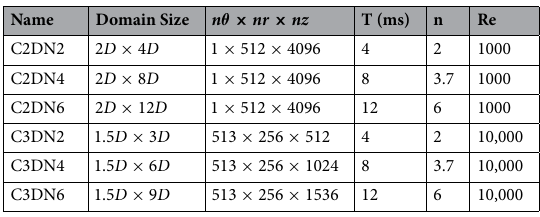
Table 2. Cases simulated.